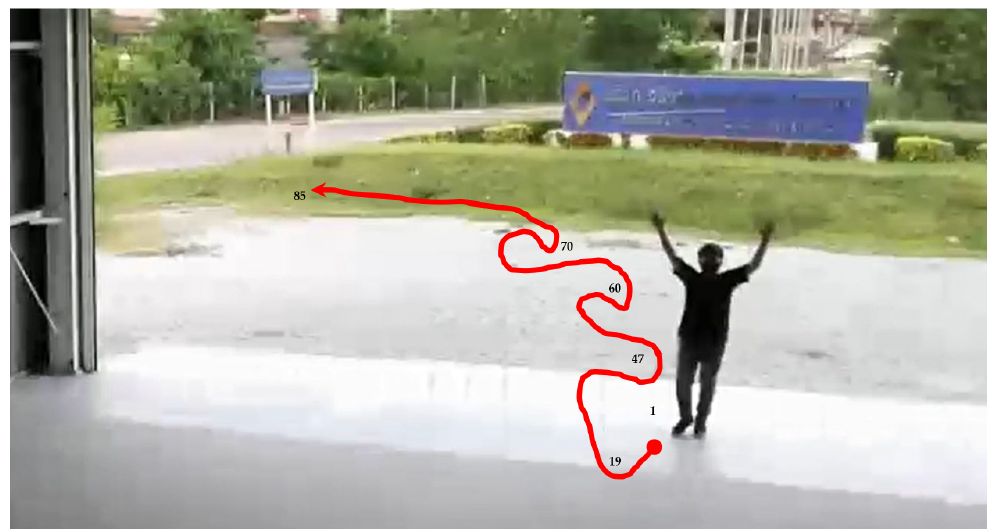
Figure 33. Path of automatic human motion tracking in an indoor–outdoor location.